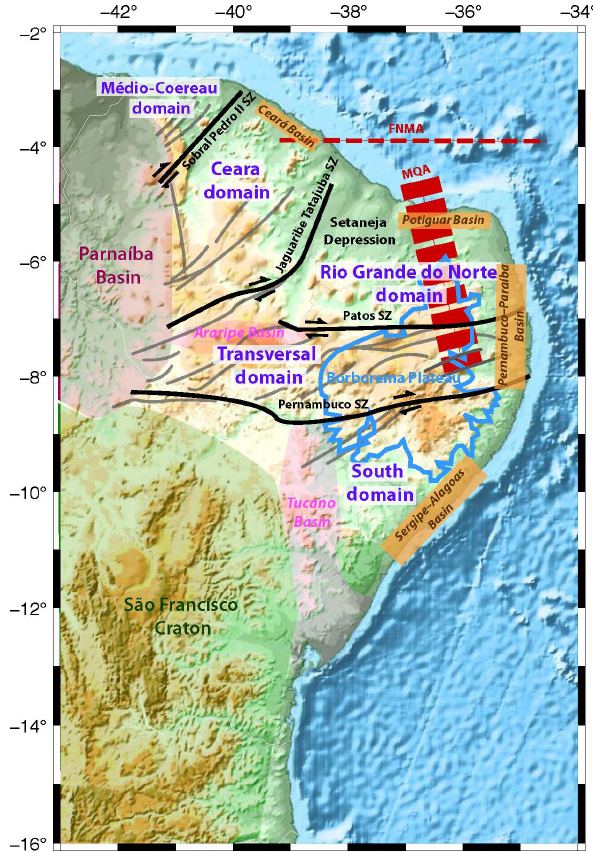
Figure 1. The main geological features of the Borborema Province superimposed on a topographic map of northeastern Brazil. Black and grey lines correspond to major shear zones (SZ), and red dashed lines correspond to the volcanic alignments of Fernando de Noronha–Mecejana (FNMA) and Macau–Queimadas (MQA). The Borborema Plateau boundaries are indicated in